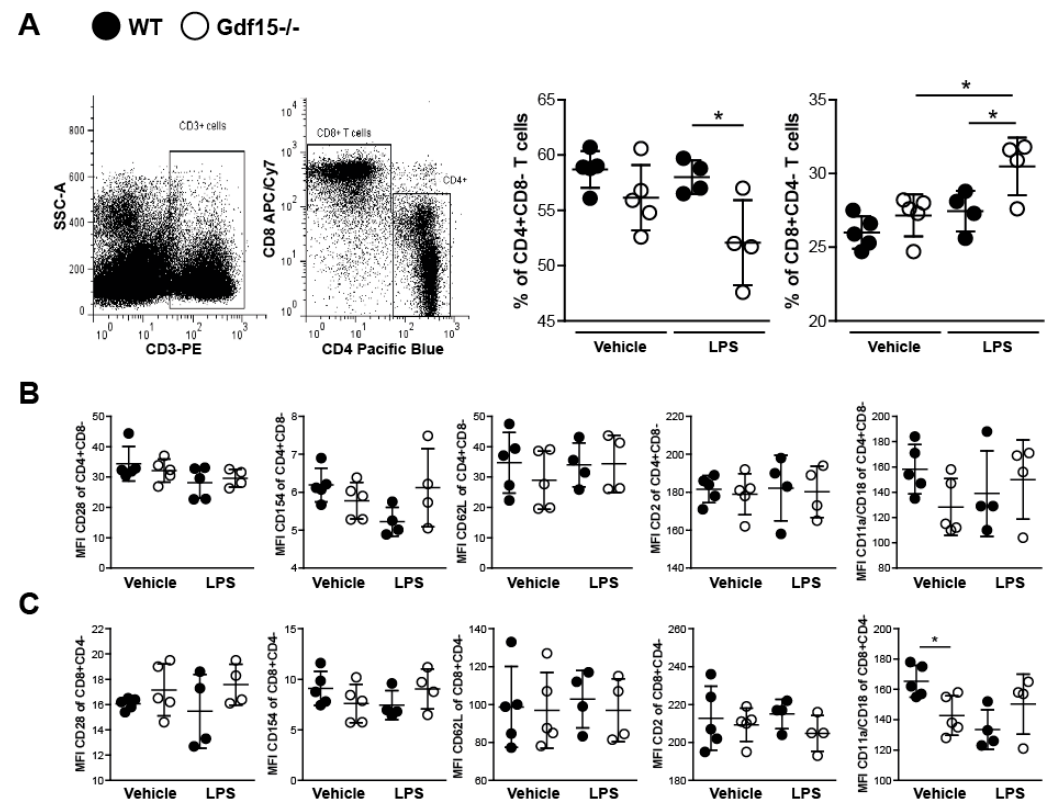
Figure 5. Stimulation of splenic T cells from WT and Gdf15 KO mice with or without LPS ex vivo. ( A ) T cells were isolated from WT and Gdf15 KO mice and stimulated with or without LPS for 24 h. The percentage of CD4 + CD8- and CD8 + CD4- T cells was quantified by flow cytometry (gating strategy, n = 4–5 per group, one-way ANOVA). ( B , C ) Mean fluorescence intensity (MFI) of the surface markers CD28, CD154, CD62L, CD2, and CD11a / CD18 on LPS-stimulated or untreated CD4 + CD8- T cells ( B ) and CD8 + CD4- T cells ( C ) ( n = 4–5 per group, one-way ANOVA). Data are mean ± SD. * p < 0.05.